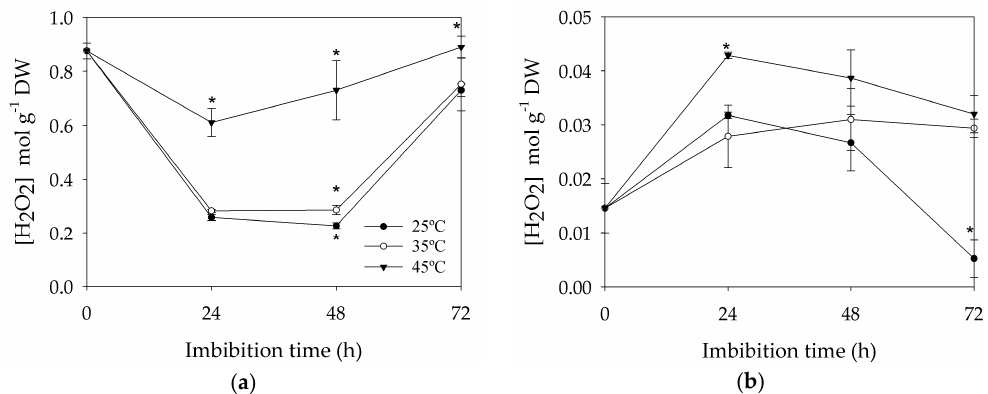
Figure 3. Hydrogen peroxide concentration in the embryonic axis ( a ) and micropylar endosperm ( b ) of Melanoxylon brauna seeds soaked at 25, 35, and 45 °C. * Indicates statistical difference between means. Vertical bars = ±SE, n = 5.